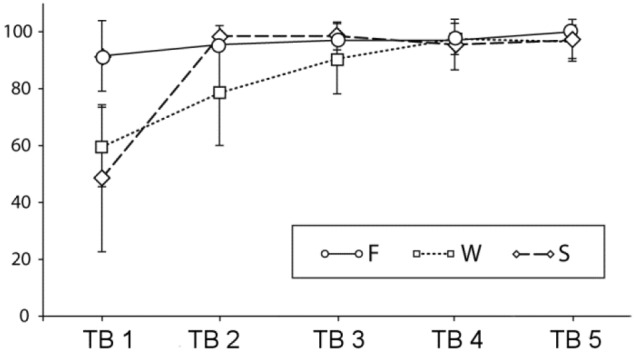
Percent correct answers and standard deviations in the sentence-picture matching task across testing blocks (TBs) (F, familiar condition; W, novel word condition; S, novel sentence structure condition).